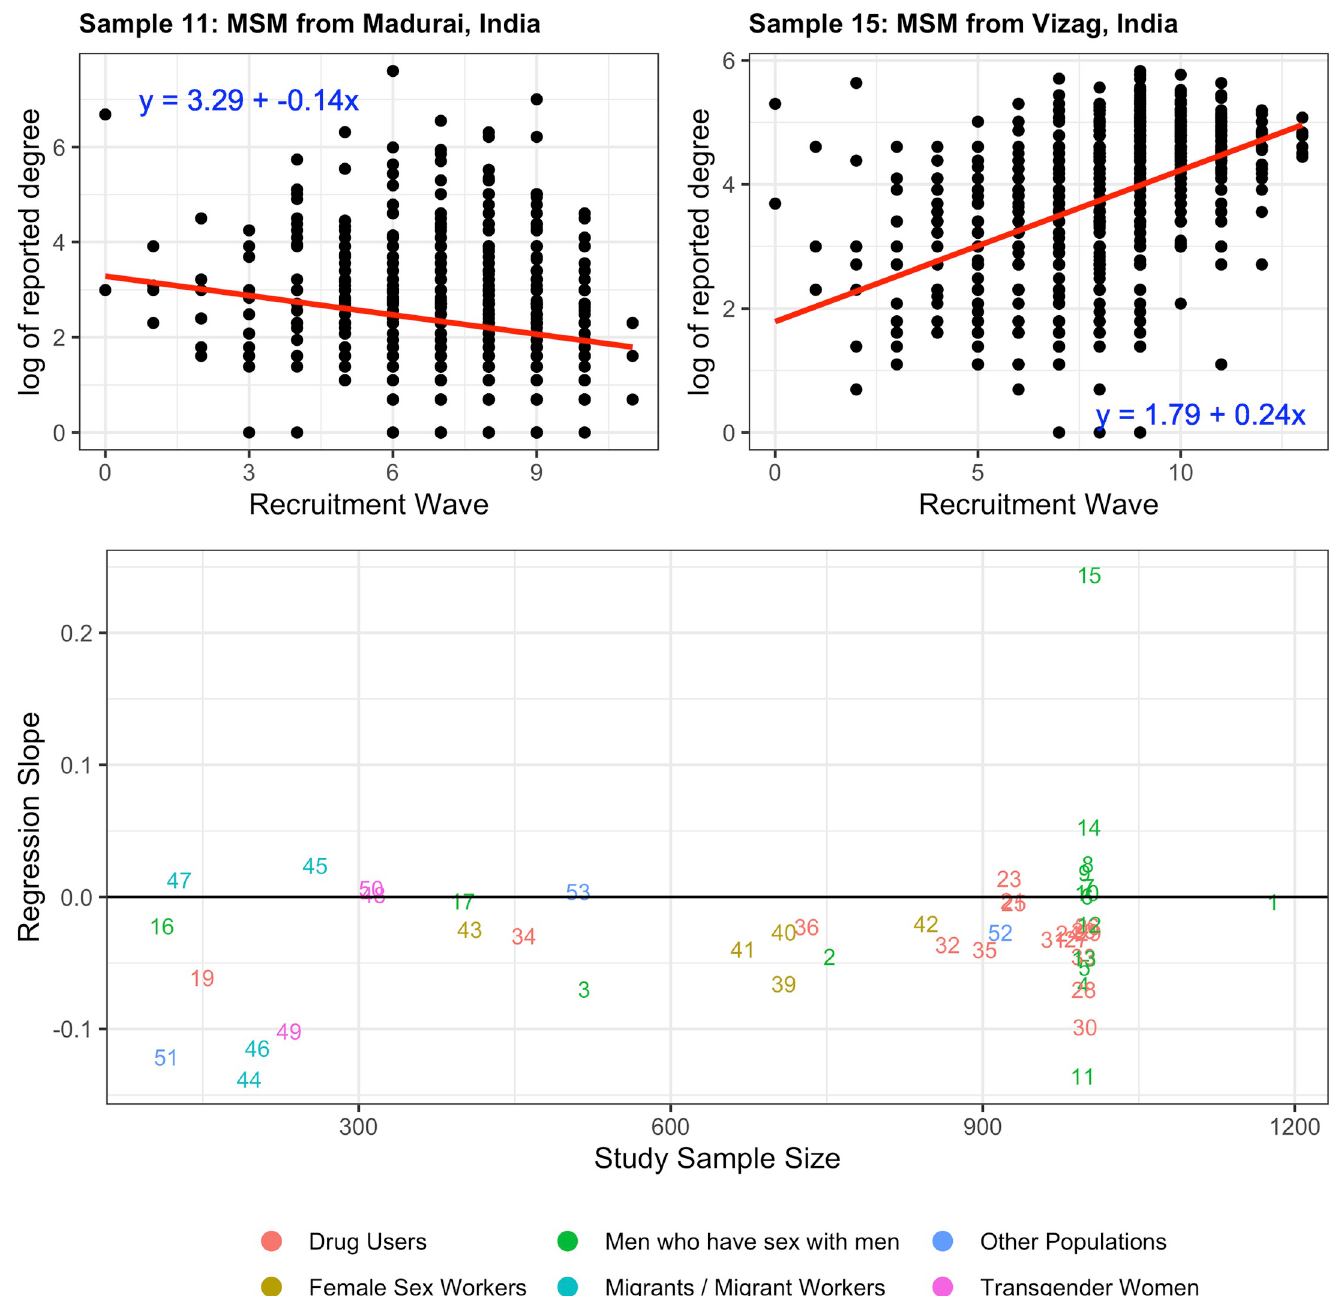
Fig 8. Change in degree over time. Change in logarithm of reported network degree, plotted as a function of sample size. Negative values indicate that the reported degree declined with successive waves. Numbers refer to the sample numbers specified in Table 1.